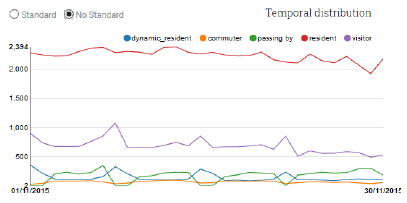
Figure 11. Municipalities of origins of presences.